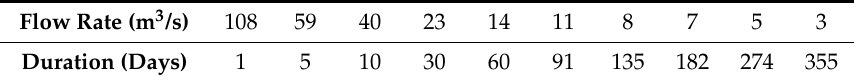
Table 1. Flow rates in the yearly duration curve used for the analysis of sediment